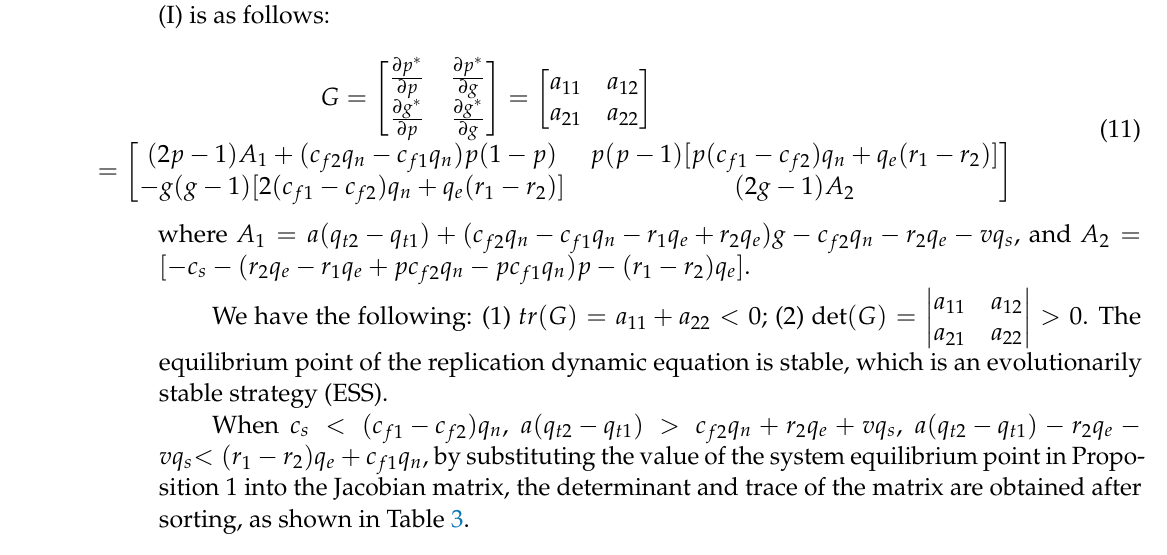
Table 3. Matrix determinant and trace expressions corresponding to the system (I) equilibrium points. Equilibrium Point ( p , g ) Matrix Determinant and Trace Expression